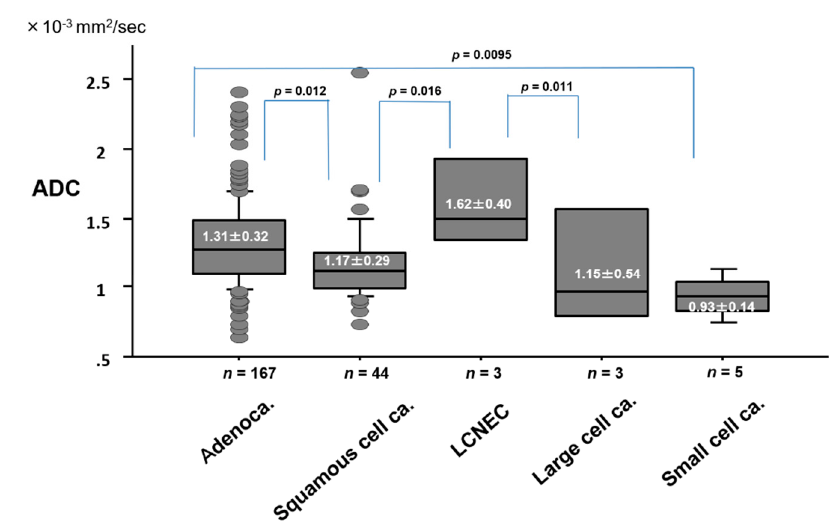
Figure 5. ADC value by pathologic cell type of lung cancer.